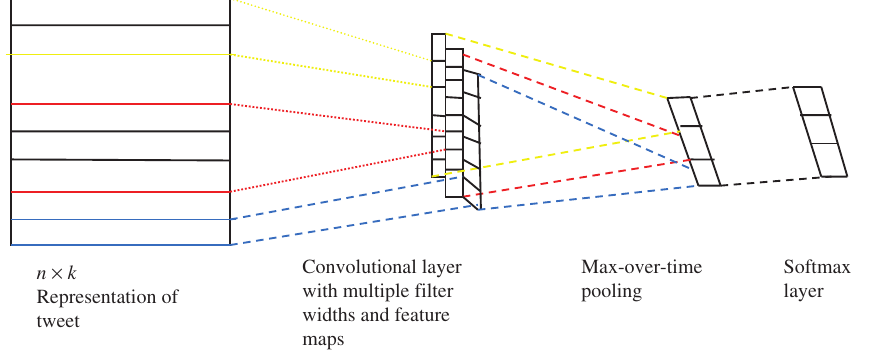
Figure 1: Model Architecture for an Example